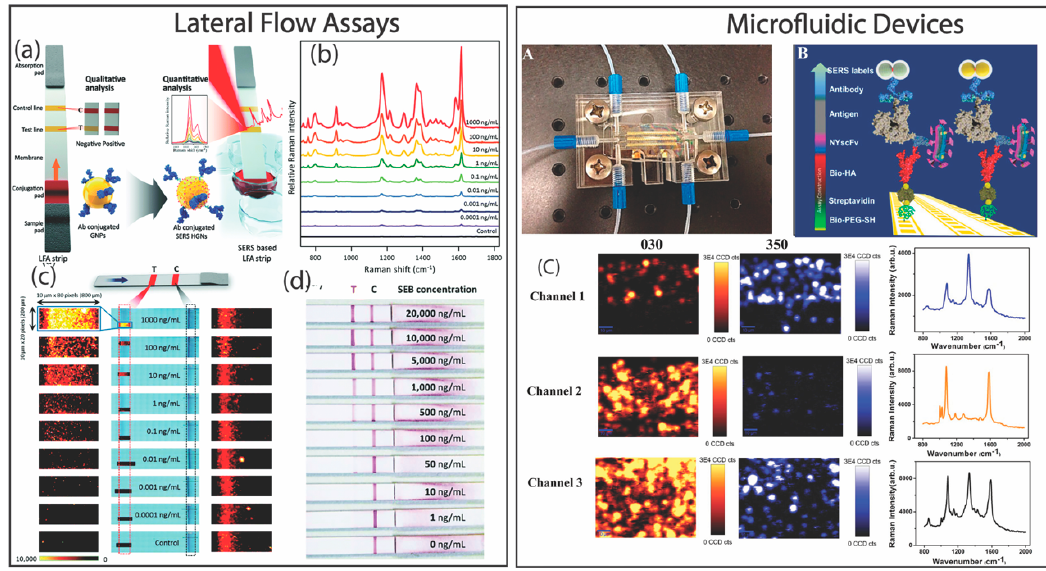
Figure 8. SERS-based diagnostic devices and assay platforms. Lateral flow assay (LFA) designs: ( a ) Representation of a traditional LFA and a SERS-based LFA that utilized Raman reporter-labeled hollow gold nanospheres to detect the presence of s taphylococcal enterotoxin B (SEB). ( b ) Average SERS spectra at the mapping area of the test zone for varying concentrations of SEB. ( c ) SERS maps acquired using a peak intensity at 1650 cm − 1 for varying concentrations of SEB concentrations. ( d ) Photograph of the LFA strip at varying concentrations of SEB concentrations. Reproduced with permission from Reference [122] Royal Society of Chemistry (2016). Microfluidic devices. ( a ) Microfluidic device used for the detection of Entamoeba histolytica using antigen as the biomarker. ( b ) Schematic representation of an indirect detection scheme designed to detect Entamoeba histolytica antigen biomarkers. It uses gold nanoparticle clusters functionalized with aromatic thiols as Raman reporters. ( c ) The duplex detection of pathogen in the three-channel microfluidic device using false-color SERS images and the corresponding average SERS spectra. Reproduced with permission from Reference [7] American Chemical Society